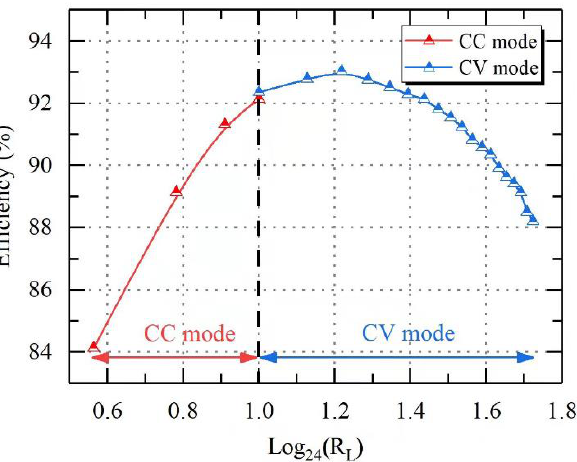
Figure 12. The power transfer efficiency profile of the S/PS−compensated WPT system.